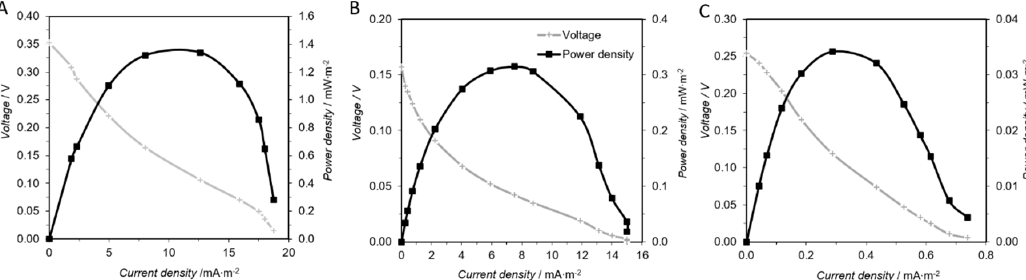
Figure 3. Power and polarization curves obtained during SMFC operation with ( A ) a carbon Toray anode and cathode (determined at day 34); ( B ) SFMC with two carbon Toray anodes and a stainless steel scourer cathode (determined at day 130); and ( C ) SMFC with stainless steel scourer anode and a carbon Toray cathode (determined at day 310).